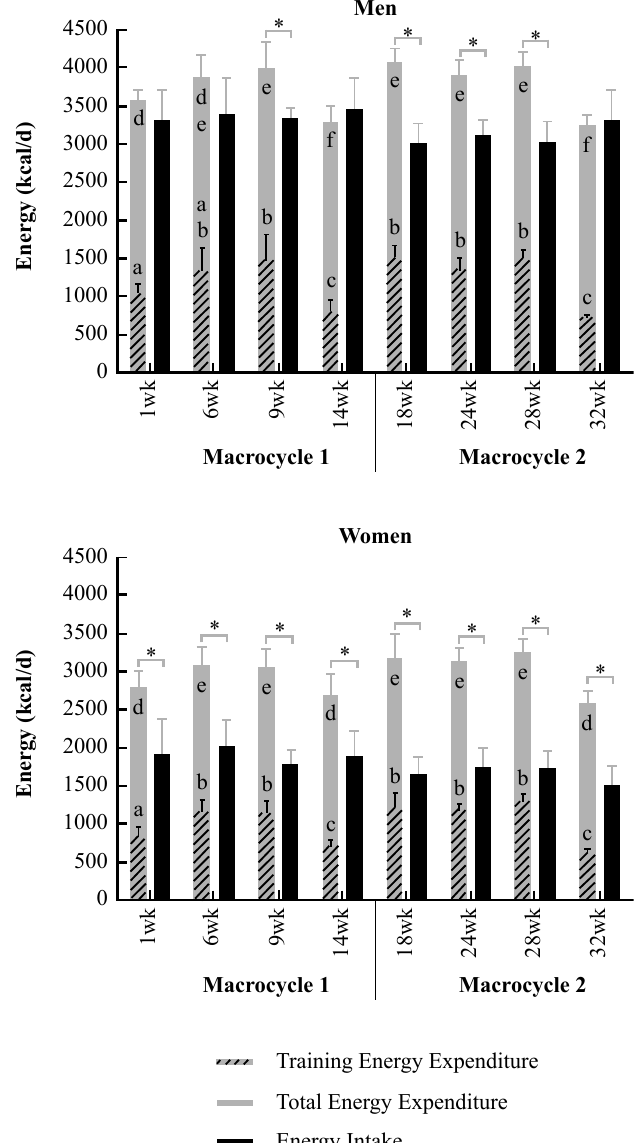
Figure 2. Total energy expenditure, training energy expenditure and energy intake for each training phase (in two macrocycles) by male (n=10) and female (n=8) swimmers (Data presented as mean ± standard deviation). Different letters indicate significant difference between training weeks for training energy expenditure (a, b, c) or total energy expenditure (d, e, f). The asterisk (*) indicate significant difference between total energy expenditure and energy